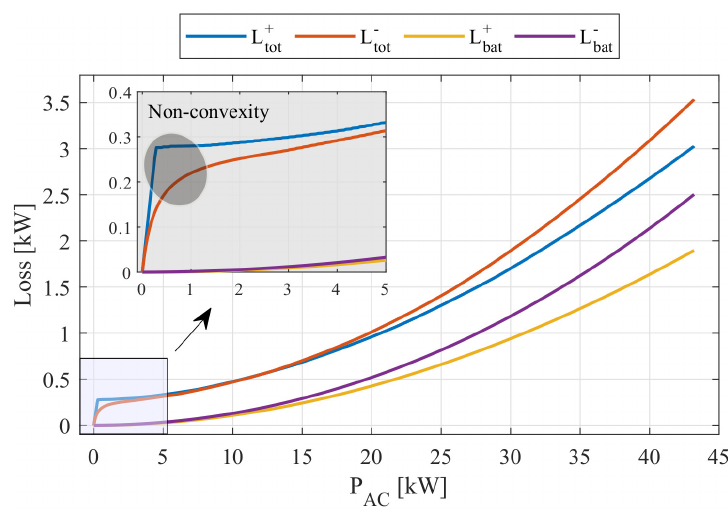
Figure A8. Loss values for different AC side power